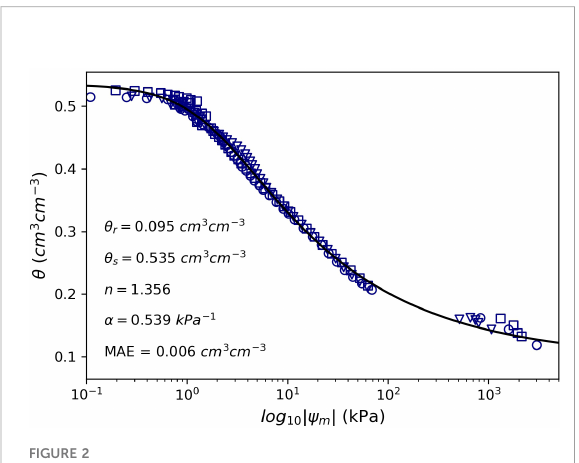
FIGURE 1 Image illustrating the experimental set up in the greenhouse. The image shows plants of Palmer amaranth growing in containers on top of automated load cells.